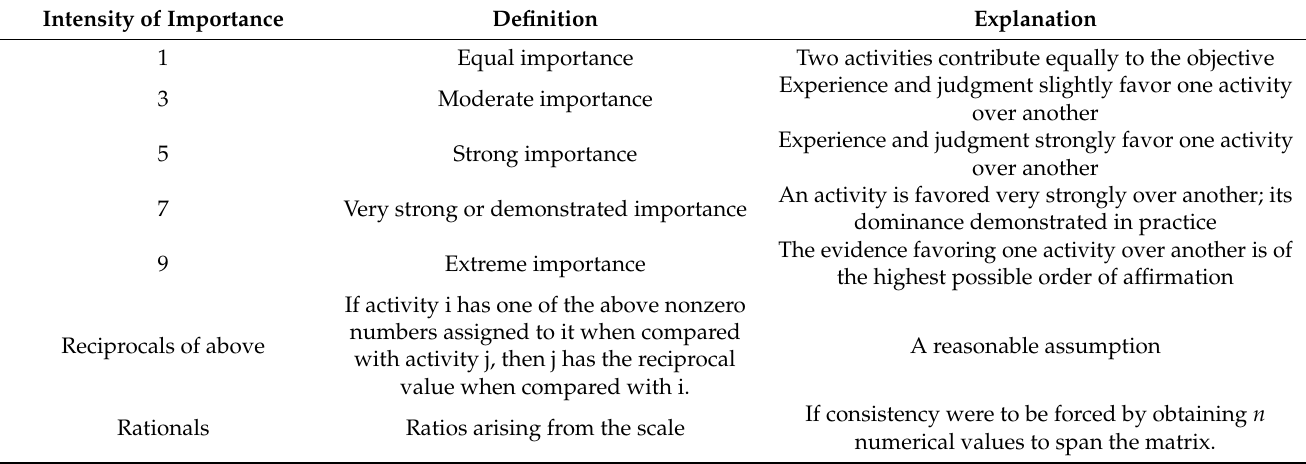
Table 2. Saaty 9-level scale score